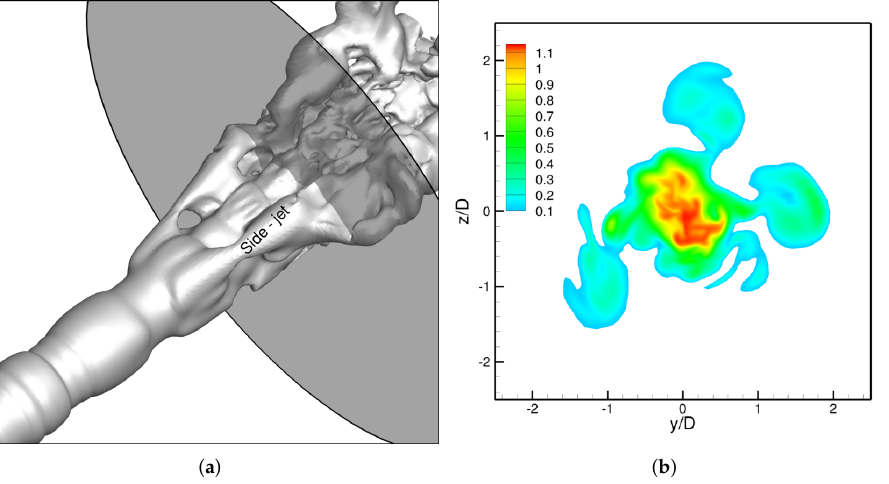
Figure 10. Iso-surfaces of the axial velocity U x / U 0 = 0.2 ( a ) and contours of axial velocity U x / U 0 at the plane perpendicular to the jet axis ( b ). The results are obtained for the case E − Cyl − Ti 0.01 .